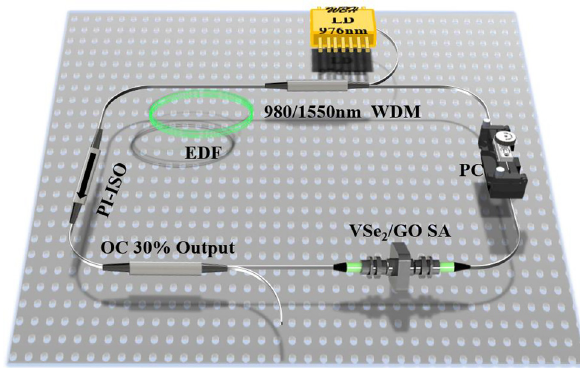
Figure 4: Diagramof the resonatordevice of passivelymode-locked EDFL.